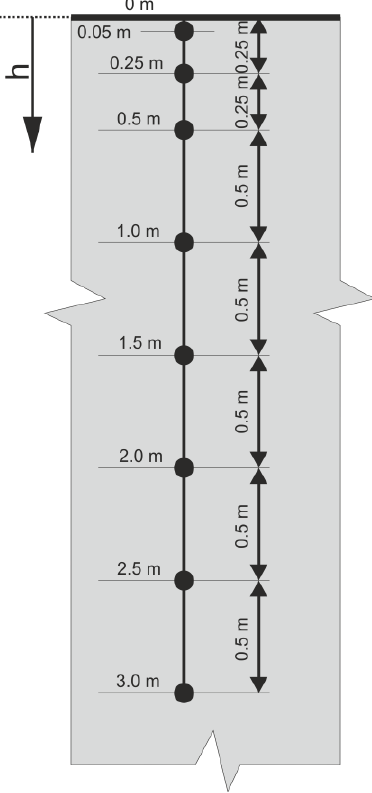
Figure 3. Diagram of the test stand for measuring the temperature distribution in the soil.